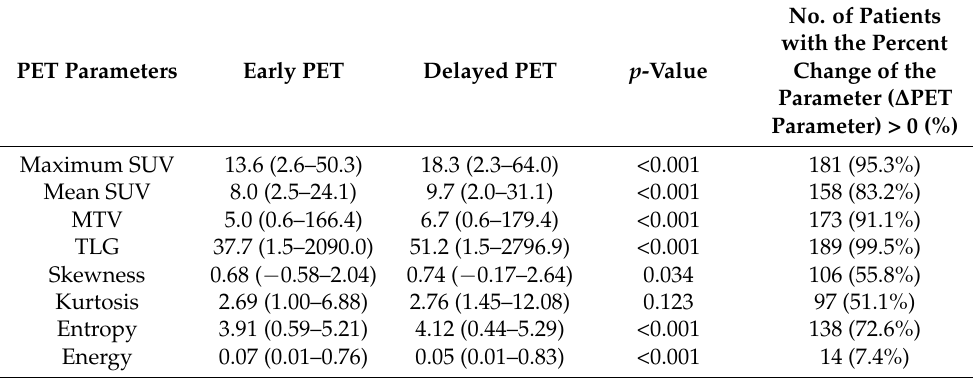
Table 2. Comparisons of eight FDG PET/CT parameters of primary lung cancer between early and delayed PET images in all enrolled patients (n =